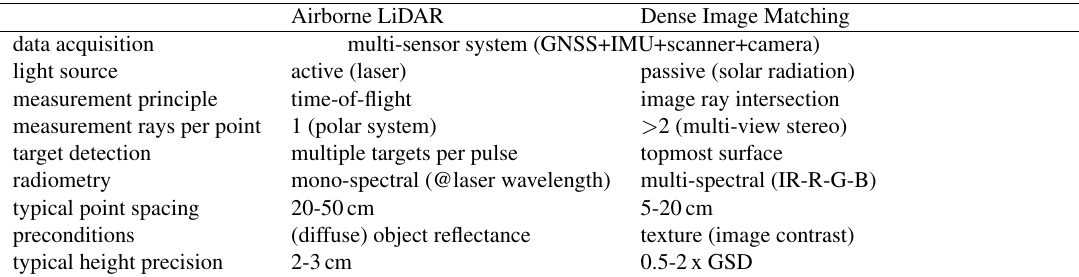
Table 1. LiDAR/DIM characteristics and properties